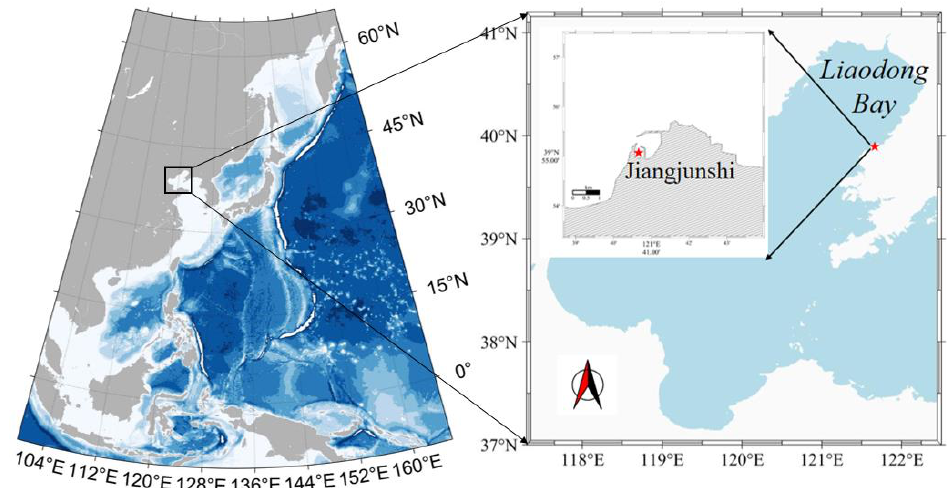
Figure 1. Locations of landfast ice survey site in Jiangjunshi Port.